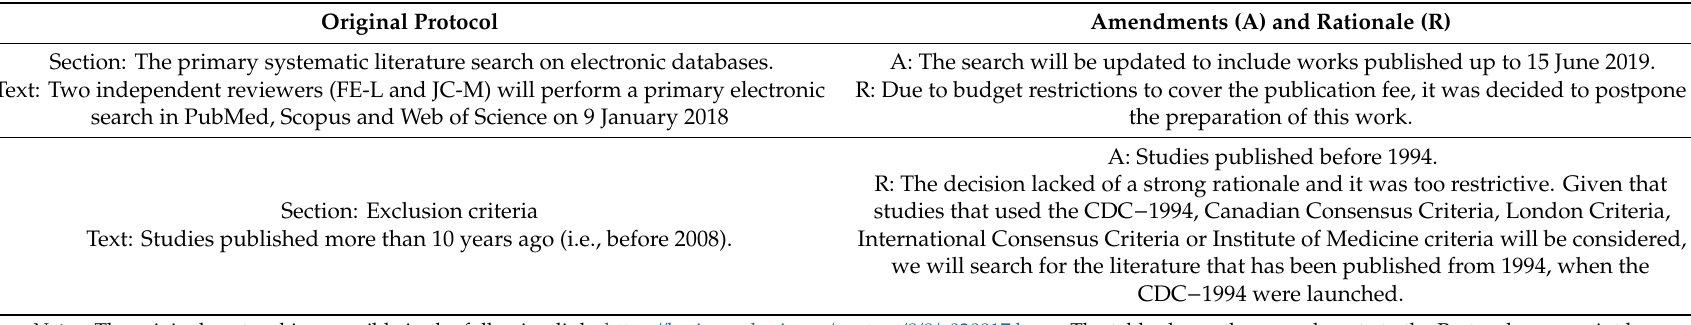
Table A1. Amendments (and rationale) to the protocol of the present systematic review.